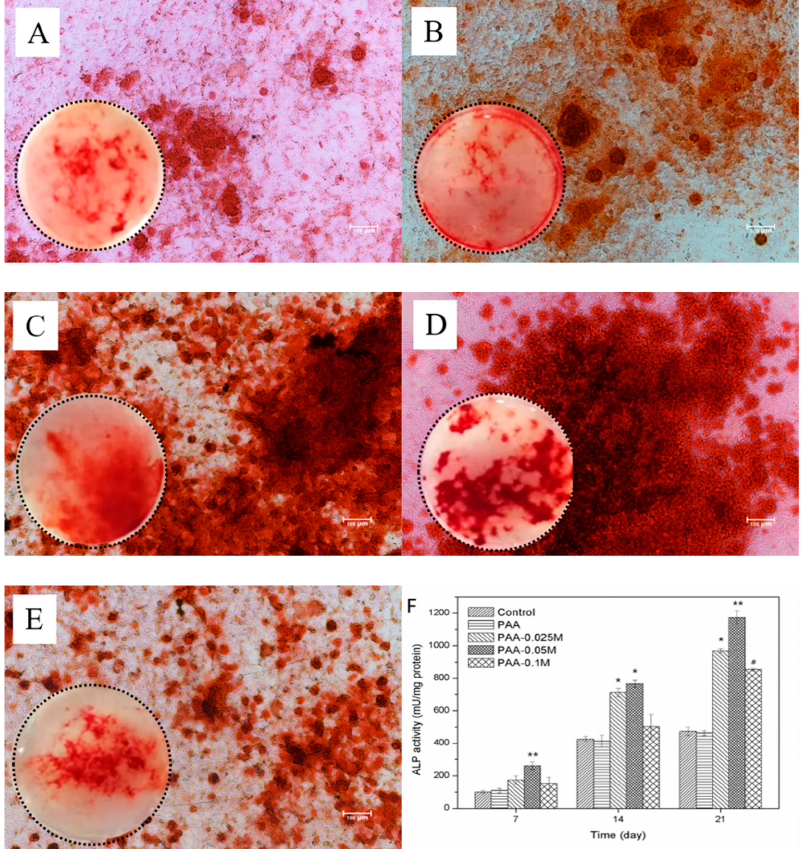
Figure 5. The Alizarin Red S staining of BMSCs at 21 days under an optical microscope, and the ALP activity of BMSCs cultured with Zn–PAA and PAA for 7, 14 and 21 days. The Alizarin Red S staining of the BMSCs cultured with ( A ) control, ( B ) PAA, ( C ) PAA–0.025M, ( D ) PAA–0.05M and ( E ) PAA–0.1M; the scale bar: 100 μ m; and their photographs in the Transwell plate under chambers (inserted); ( F ) the ALP activity of BMSCs (** p < 0.05 compared to each other sample; * p < 0.05 compared to the control, PAA or PAA–0.1M; # p < 0.05 compared to the control or PAA).